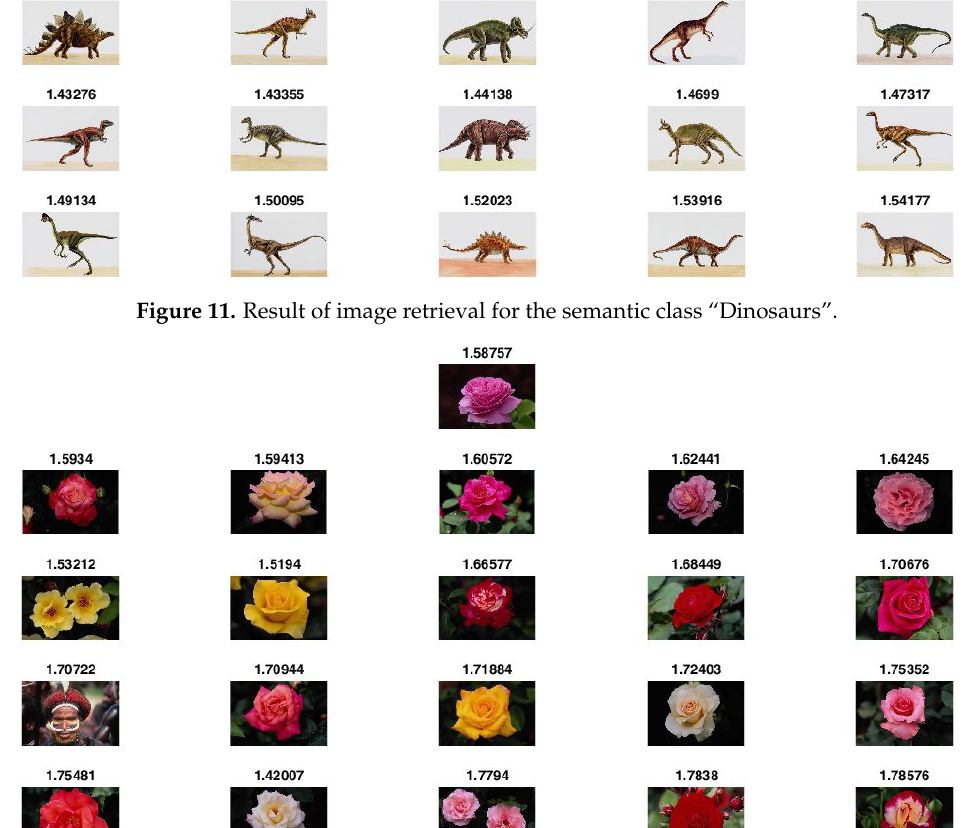
Figure 12. Result of image retrieval for the semantic class